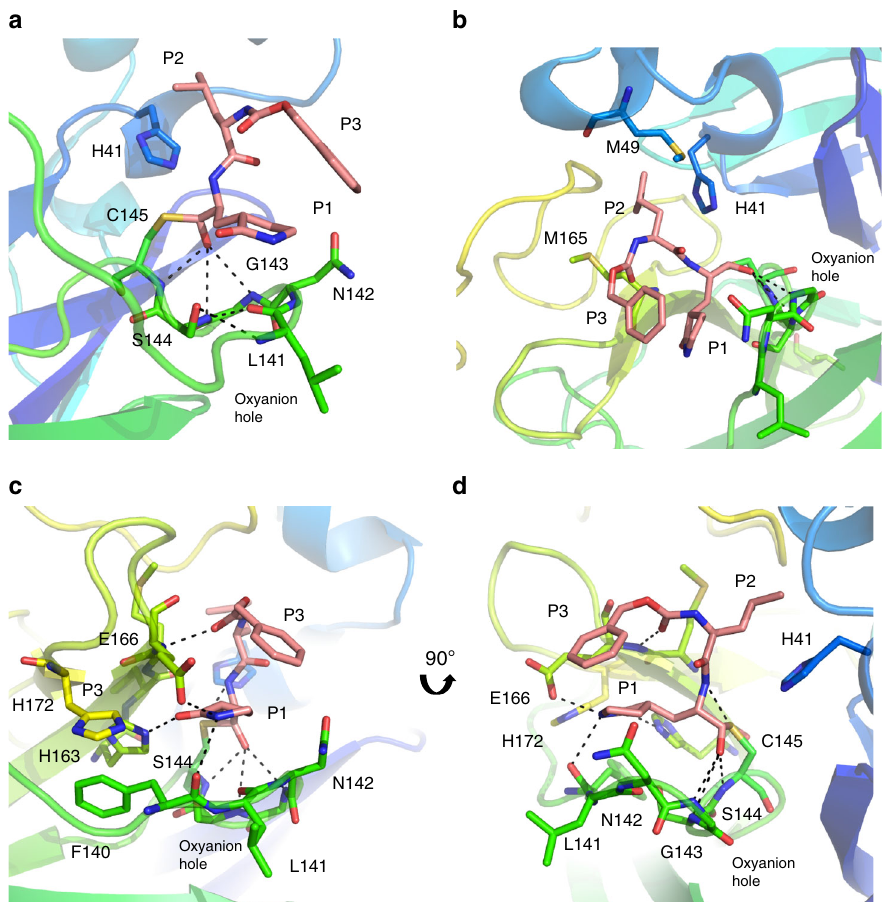
Fig. 3 GC373 binds in the active site pocket of SARS-CoV-2 M pro . a GC373 forms a covalent bond with C145, and the oxyanion is stabilized by backbone H-bonds with G143, S144, and C145. b The P2 position of GC373 is stabilized by a hydrophobic pocket by the general base H41, and residues M49, and M165. c , d H-bonds are established with GC373 and side chains of H163 and E166, as well as backbone of residue E166. SARS-CoV-2 M pro is represented in cartoon representation with the inhibitor in pink. P1, P2, and P3 of the peptidyl inhibitor are indicated. PDB